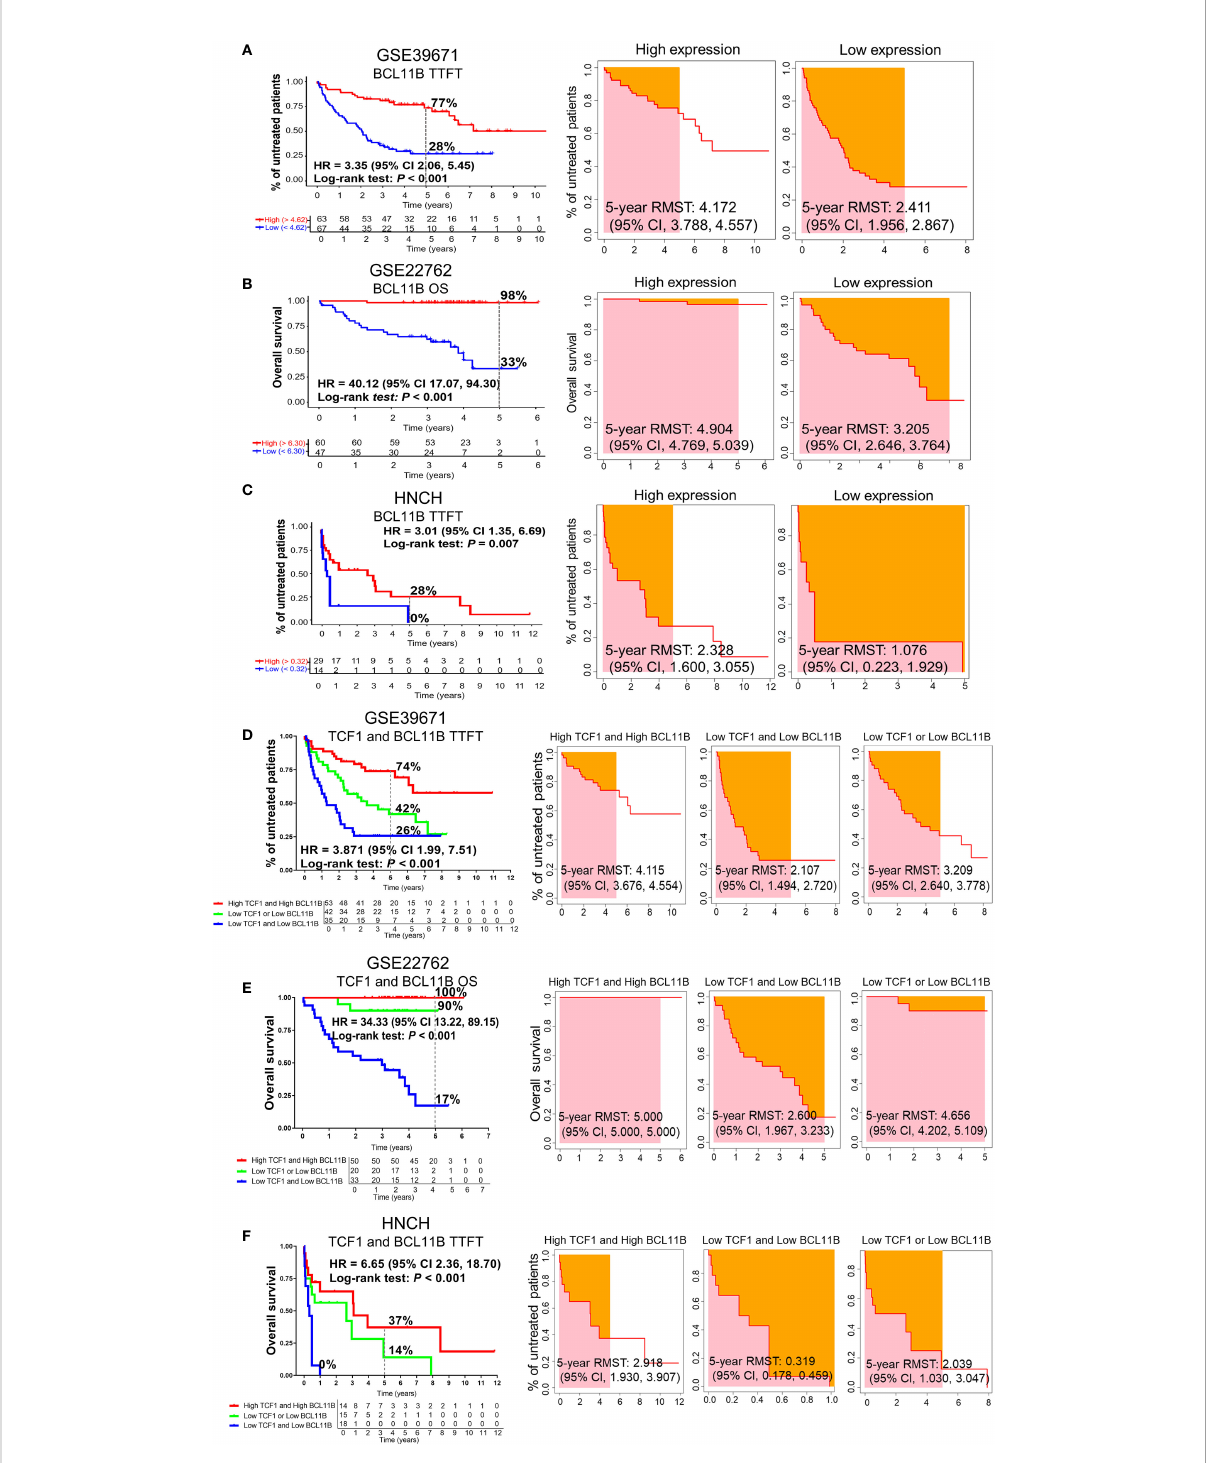
FIGURE 4 The predictive effects of BCL11B alone and in combination with TCF1 on the TTFT and OS of patients with CLL. (A) The TTFT (left panel) and RMST (right panel) for the high and low BCL11B expression groups in the GSE39671 dataset. (B) The OS (left panel) and RMST (right panel) for the high and low BCL11B expression groups in the GSE22762 dataset. (C) The TTFT (left panel) and RMST (right panel) for the high and low BCL11B expression groups in the HNCH. (D) The effects of TCF1 combined with BCL11B on TTFT (left panel) and RSMT (right panel) in the GSE39671 dataset. (E) The effects of TCF1 combined with BCL11B on OS (left panel) and RSMT (right panel) in the GSE22762 dataset. (F) The effects of TCF1 combined with BCL11B on TTFT (left panel) and RSMT (right panel) in the